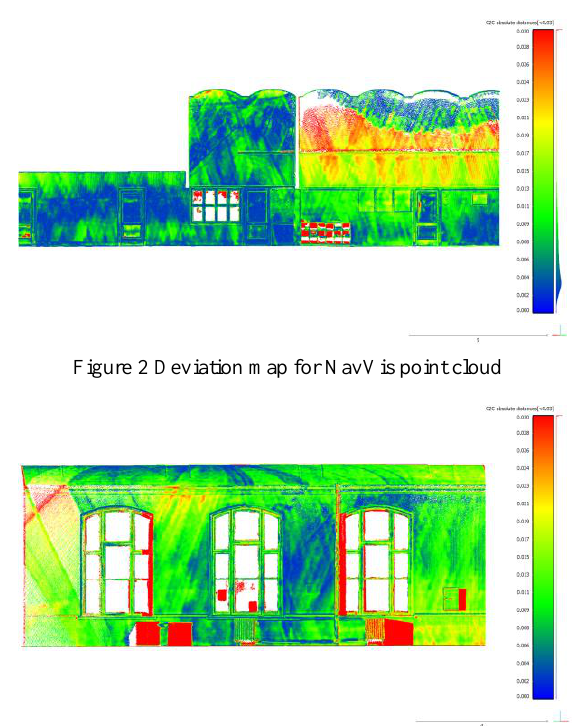
Figure 6 Capturing architectural details with TLS (black) and MMS-NavVis